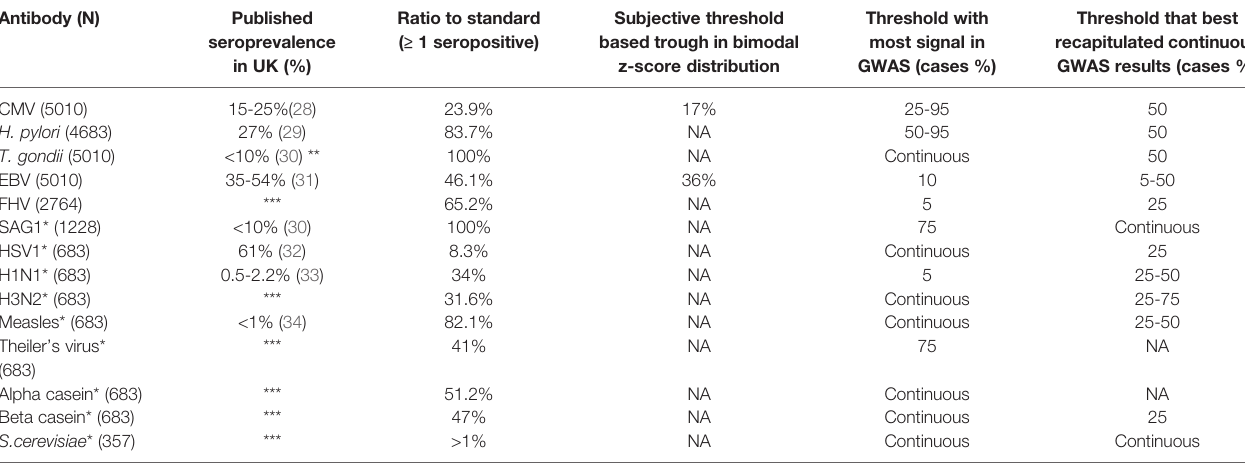
TABLE 1 | Suggested antibody thresholds based on percentage of cases using ALSPAC seven-year clinic data compared to published seroprevalence in the United Kingdom. Antibody (N) Published Ratio to standard Subjective threshold Threshold with seroprevalence ( ≥ 1 seropositive) based trough in bimodal most signal in UK (%) z-score distribution